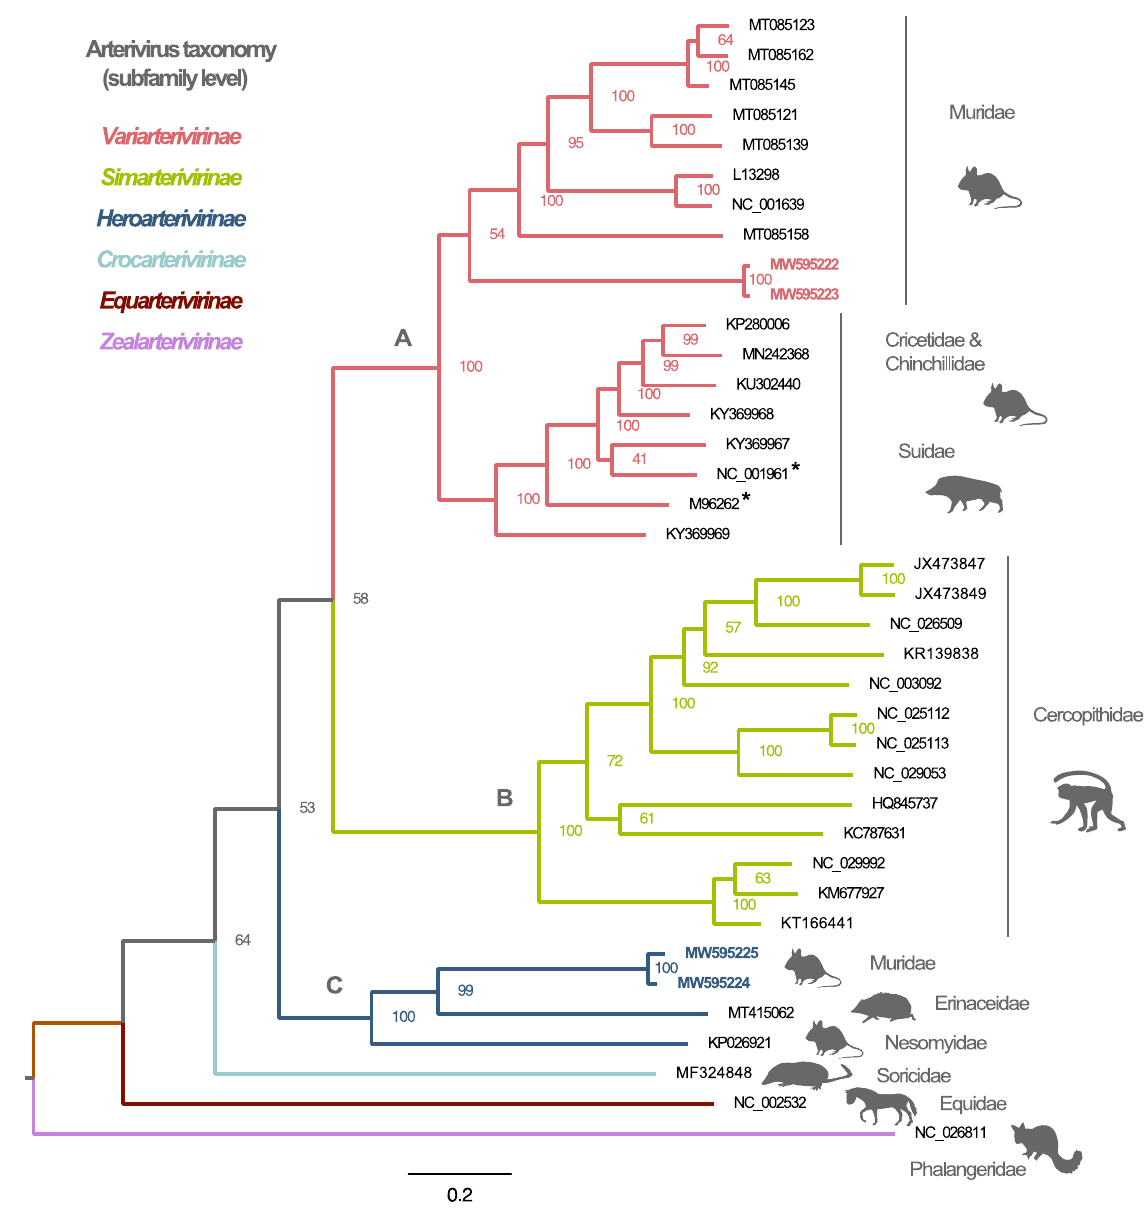
Figure 2. Phylogenetic reconstruction of the mammalian-borne arteriviruses. Maximum likelihood phylogenetic tree based on the ORF1ab of all putative arterivirus species for which coding-complete genomes are available. Silhouettes and descriptions in grey color denote mammalian host families. Numbers next to the internal nodes indicate bootstrap support, while branches are colored according to the assigned arterivirus subfamilies. Asterisks indicate the two porcine arterivirus genomes. Our novel genomes are labelled in highlighted bold accession numbers (red: Lopma and blue: Praja). Phylogenetic clustering shows that Lopma virus strains group within the subfamily Variarterivirinae , while Praja strains are mostly related to viruses from the subfamily Heroarterivirinae . Clades A, B and C have been provisionally named to facilitate discussion of the various mammalian arterivirus lineages.